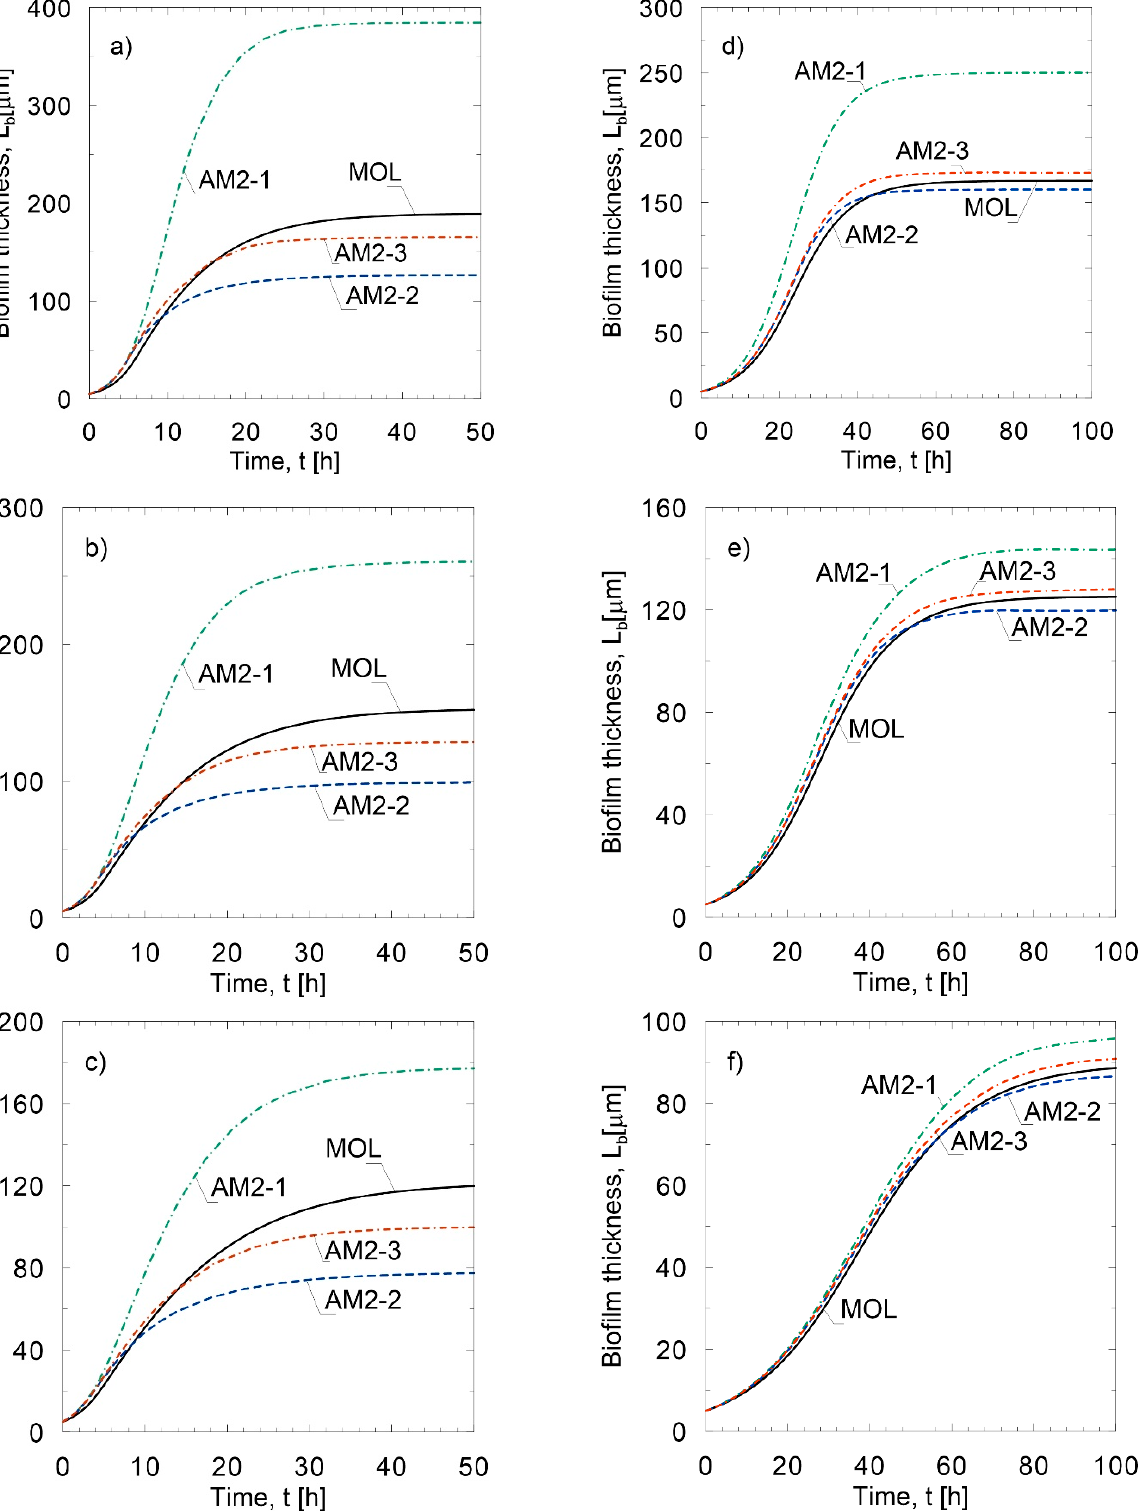
Figure 5. Comparison of average dimensionless substrate concentration (left column), biofilm thickness obtained in the dynamical simulation of biofilm growth with the use of the exact model (solid lines) and approximate model AM1 (dashed lines); ( a , b ) nitrite oxidation by nitrifying bacte ‐ ria; ( c , d ) glucose utilization by Pseudomonas aeruginosa ; ( e , f ) phenol degradation by Pseudomonas putida .